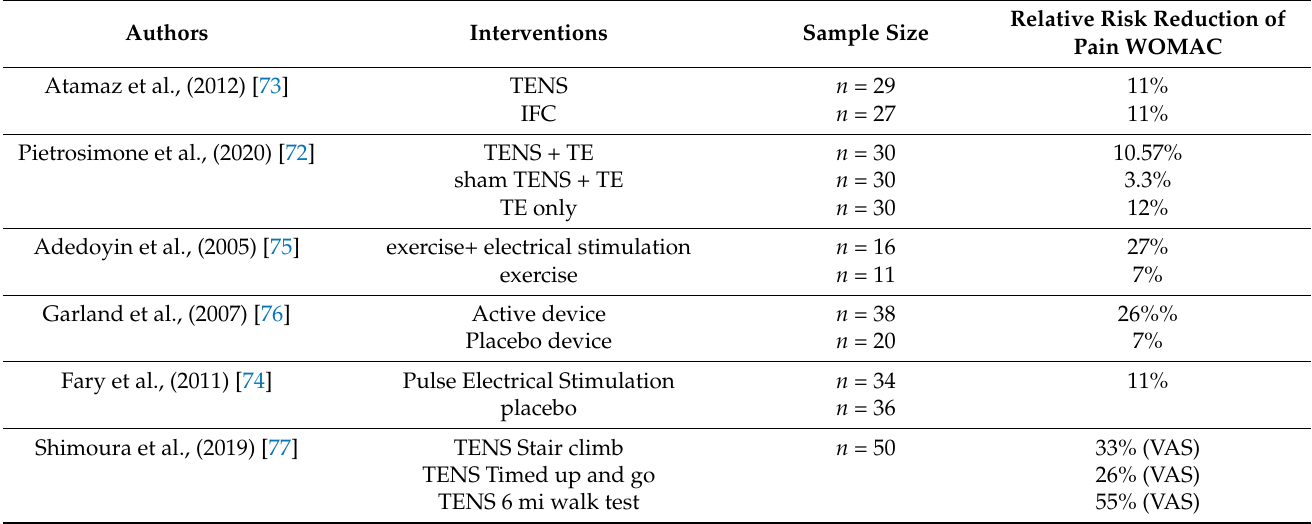
Table 5. Summary of the findings from the six papers with interventions regarding electrical